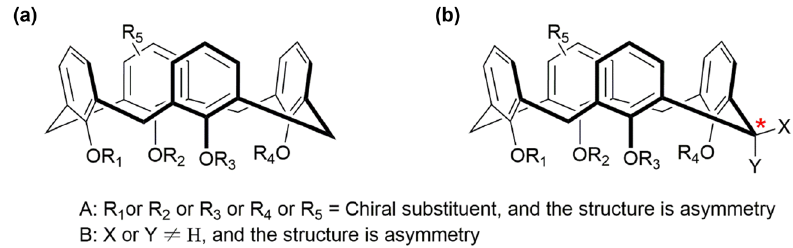
Figure 1: Intrinsically chiral calix [ 4 ] arenes: ( a ) shows inherently chiral calixarenes and ( b ) shows bridging chiral calixarenes.